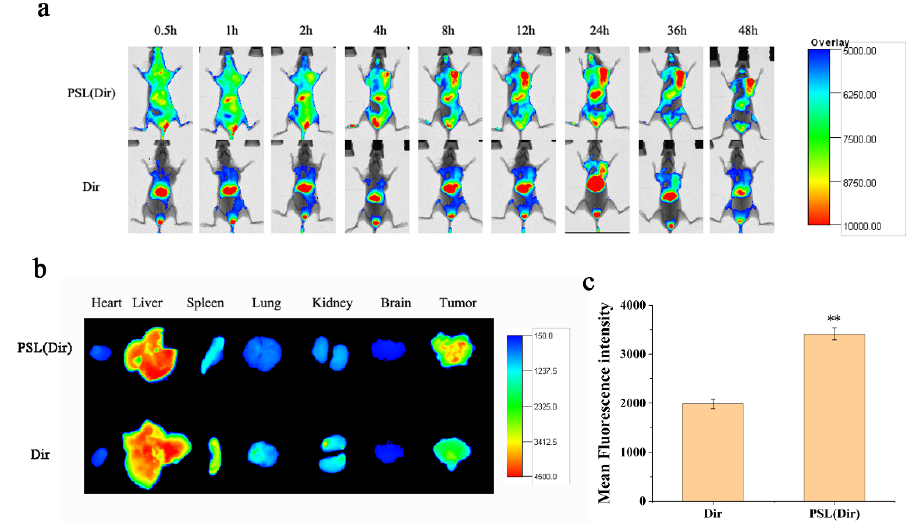
Figure 9. ( a ) In vivo fluorescent images at different times after intravenous injection of PSL (Dir) and Dir. ( b ) Tissue fluorescent images at 48 h post-injection in heart, liver, spleen, lung, kidney, brain and tumor. ( c ) The fluorescence intensity of tumor regions was analyzed using NIH Image J software. Data were expressed as mean ± SD (n = 3), ** p < 0.01 compared with the Dir